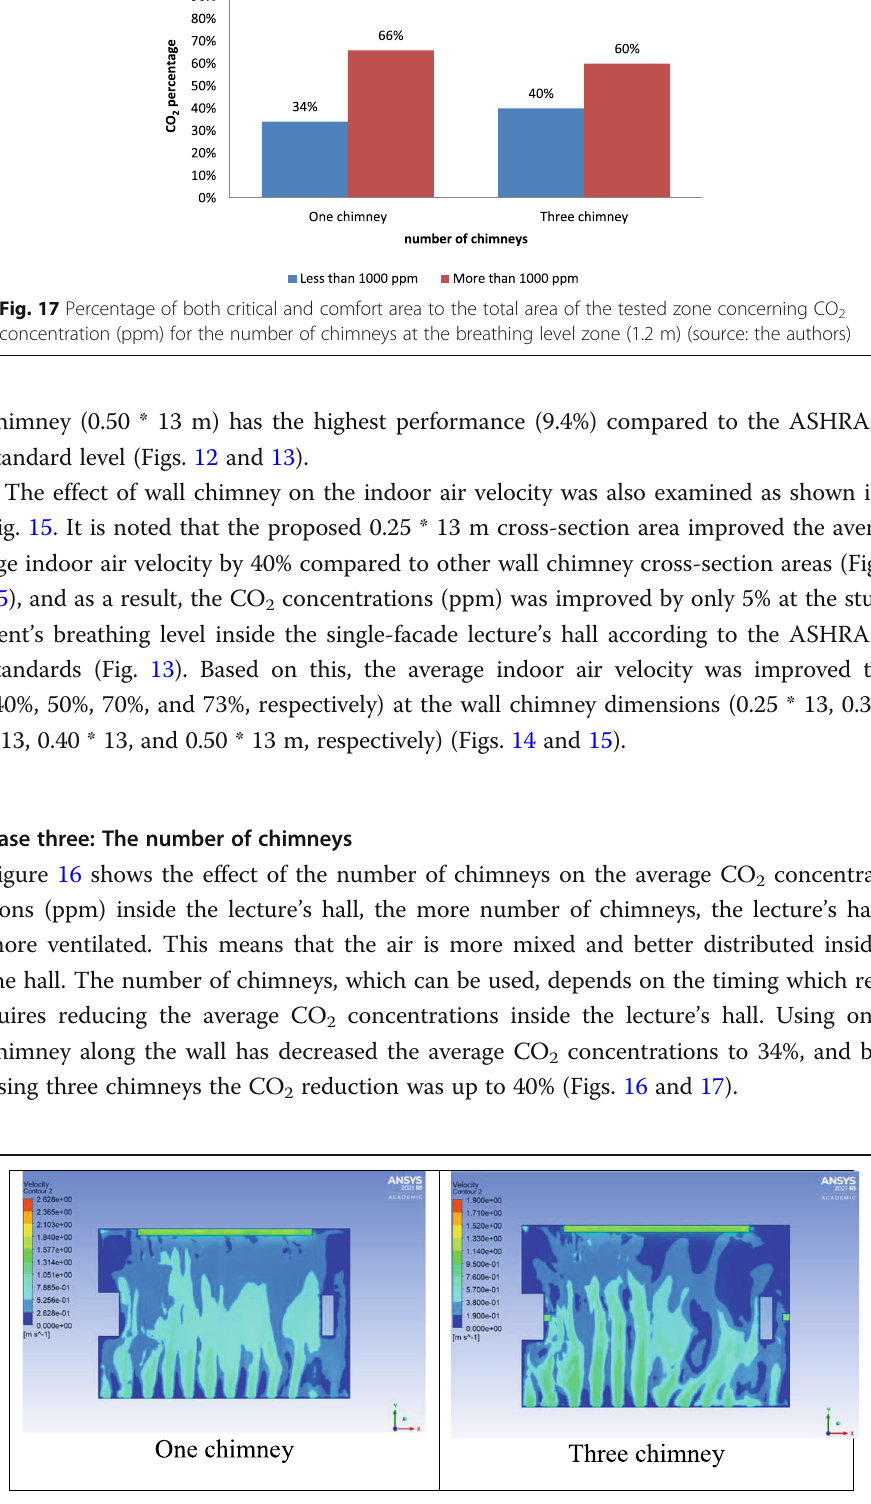
Fig. 18 Contours of air velocity for the number of chimneys at the breathing level zone (1.2 m), output from the ANSYS CFD model